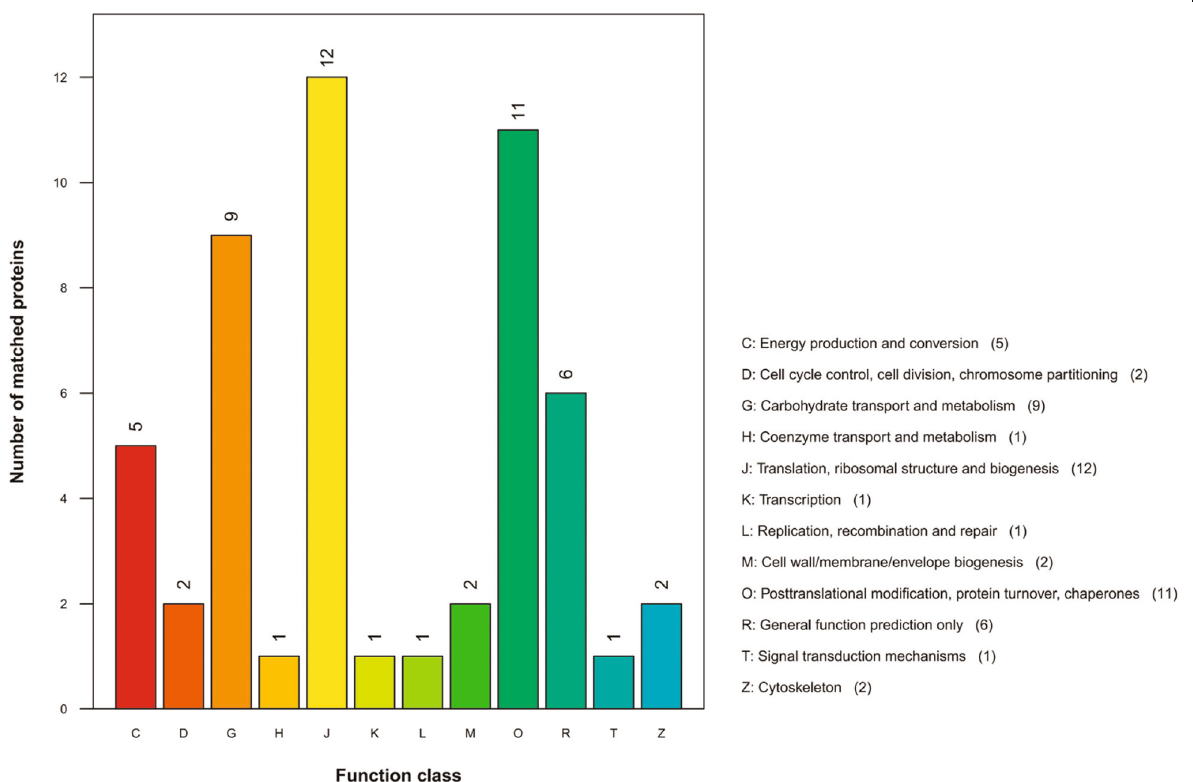
Fig. 6 COG function classification of proteins identified in Fraction